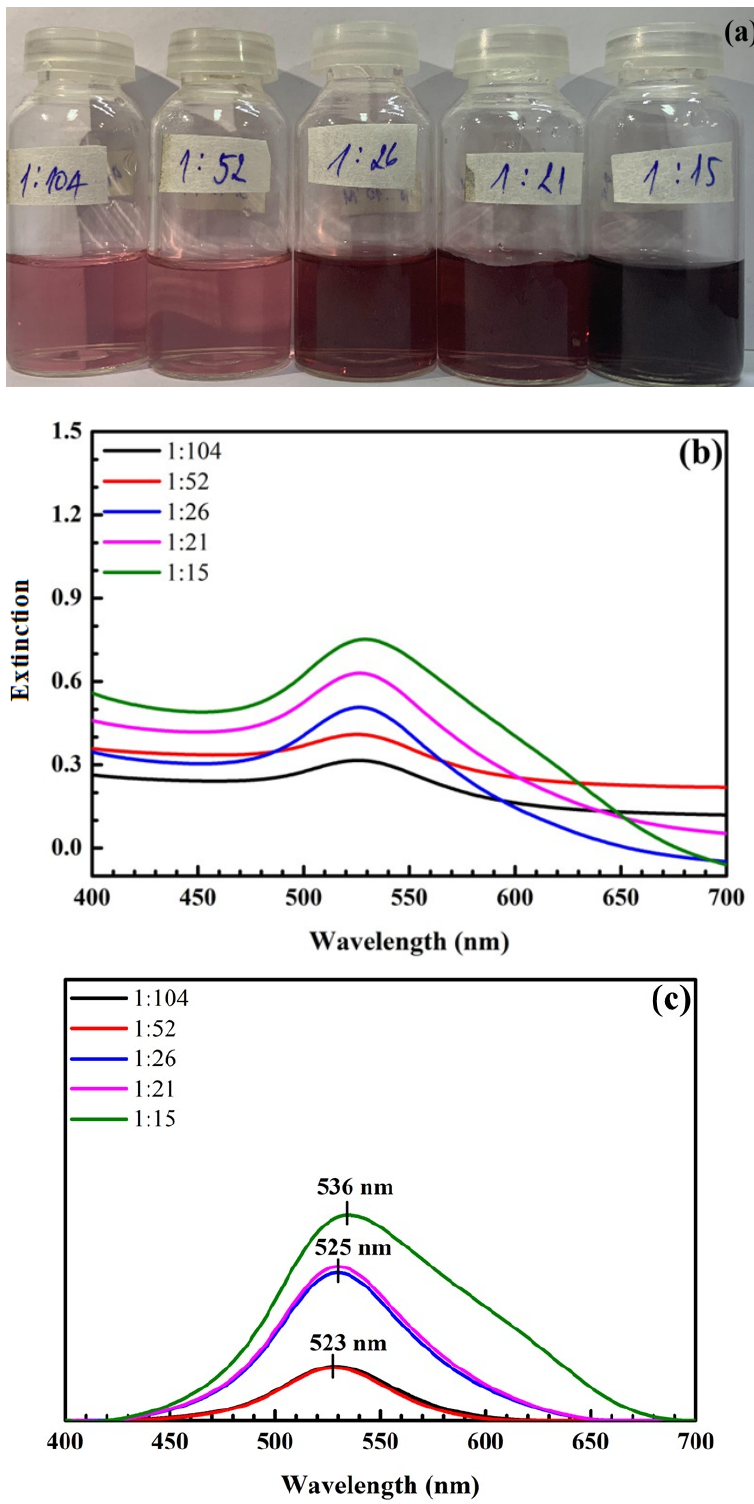
Figure 3. Pictures of samples at different ratios of HAuCl 4 to sodium citrate ( a ). UV-Vis spectra of samples at different ratios of HAuCl 4 to sodium citrate ( b ) and their UV-Vis baseline spectra ( c ).